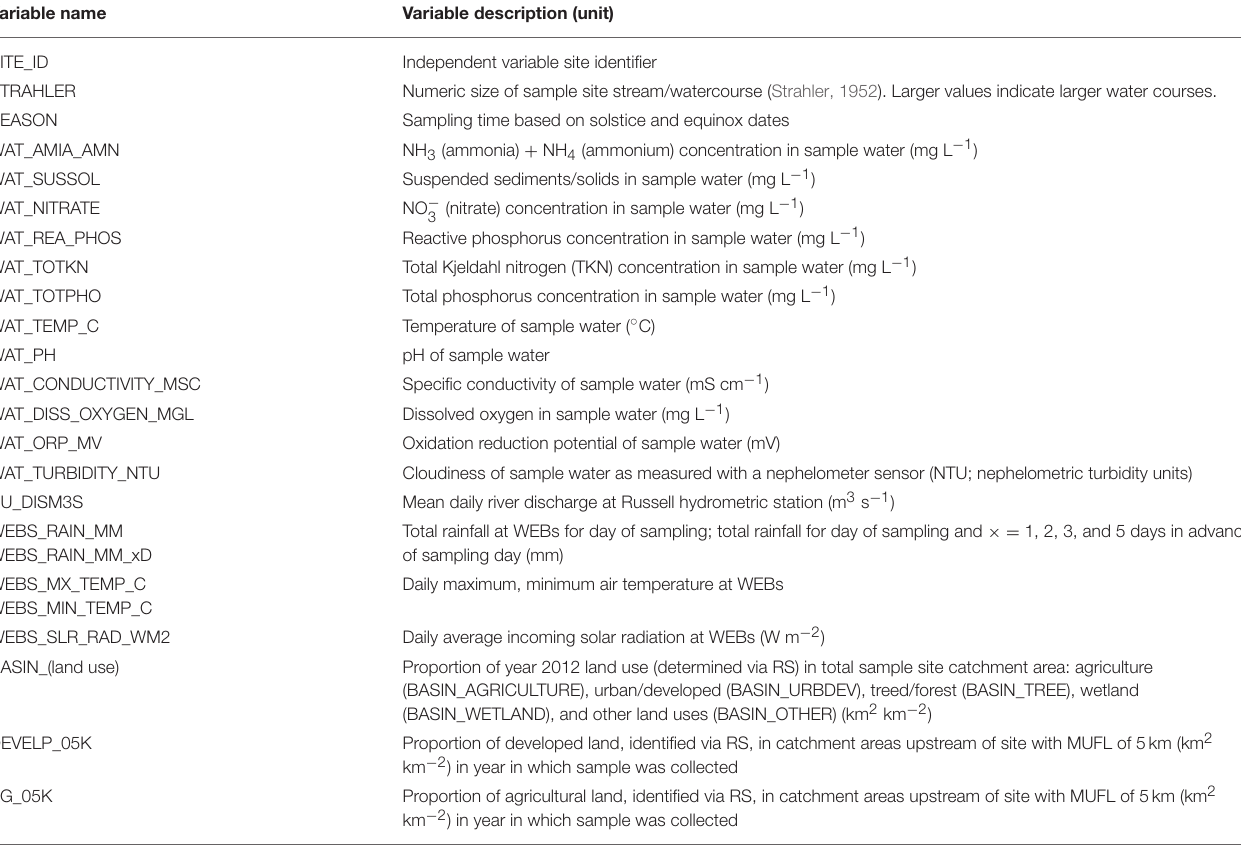
TABLE 1 | Land use and water physiochemcial/environmental variables used for data